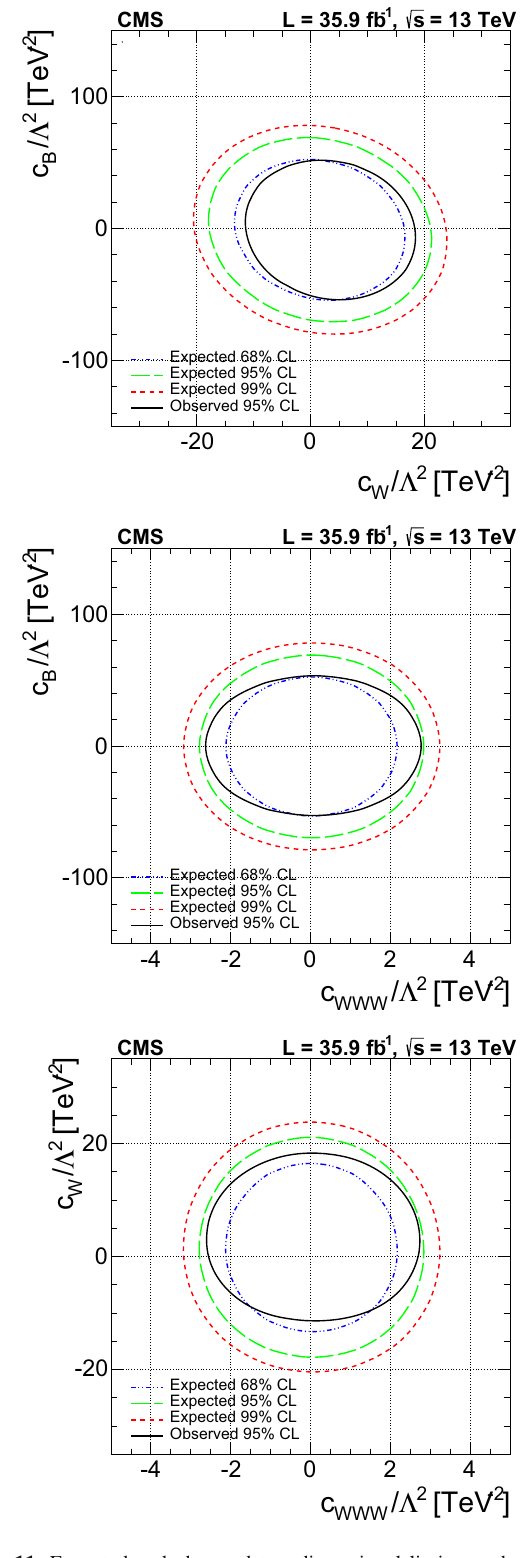
Fig. 11 Expected and observed two-dimensional limits on the EFT parameters at 95%